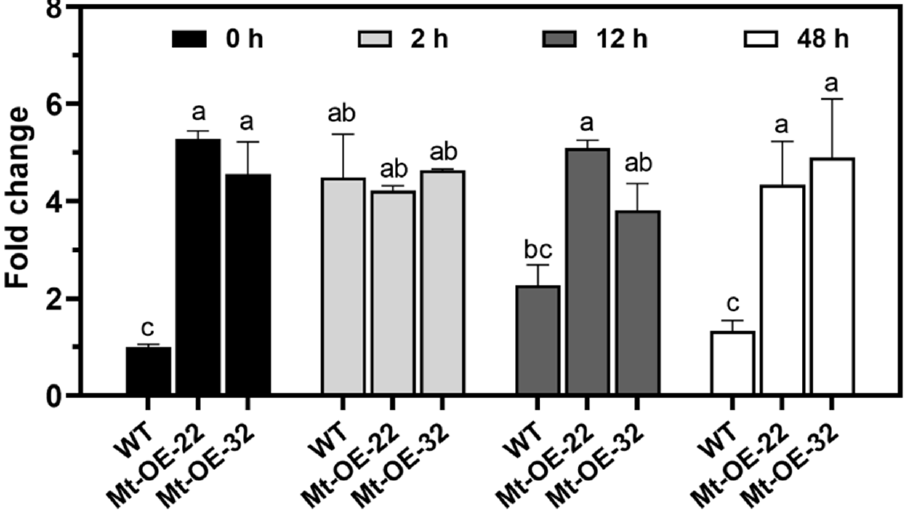
Figure 5. Transcriptional expression profile of Mtr-miR319a in M. truncatula plants after salt stress. The M. truncatula plants of the WT and the Mtr-miR319a overexpression lines of Mtr-OE-22 and Mtr-OE-32 were exposed to 150 mM NaCl for 0, 2, 12, and 48 h. The values are shown as the mean ± standard error (SE); n = 3 for all groups. The bars represent the SE. Bars with different lowercase letters indicate statistically significant differences at p < 0.05 based on ANOVA.